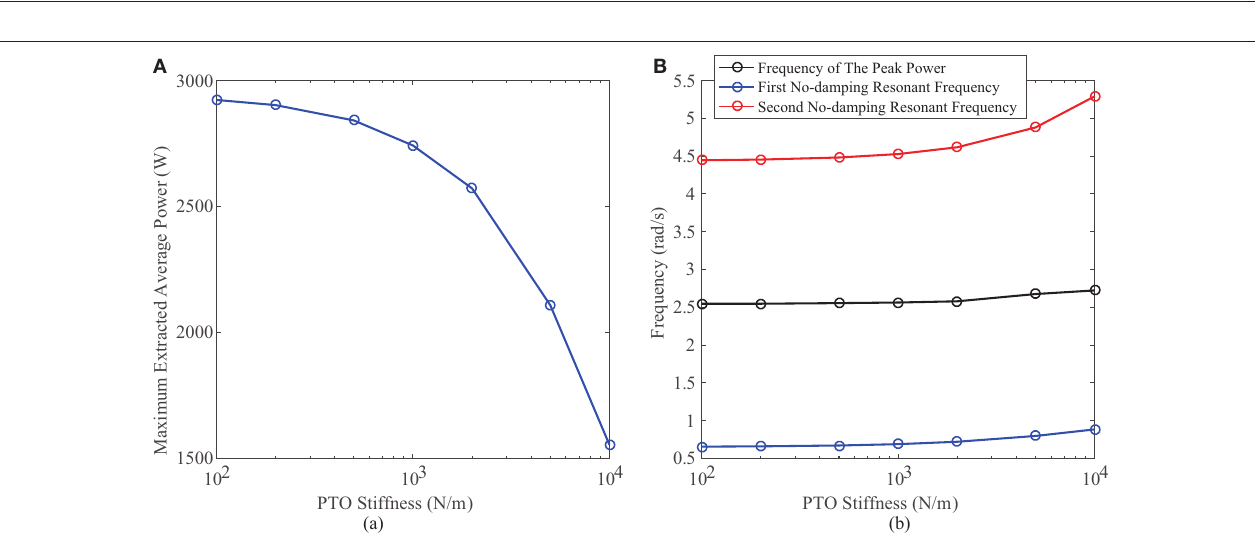
FIGURE 3 | Extracted average power vs. wave frequency at various PTO stiffness. (A) Without floater dragging. (B) With floater dragging.